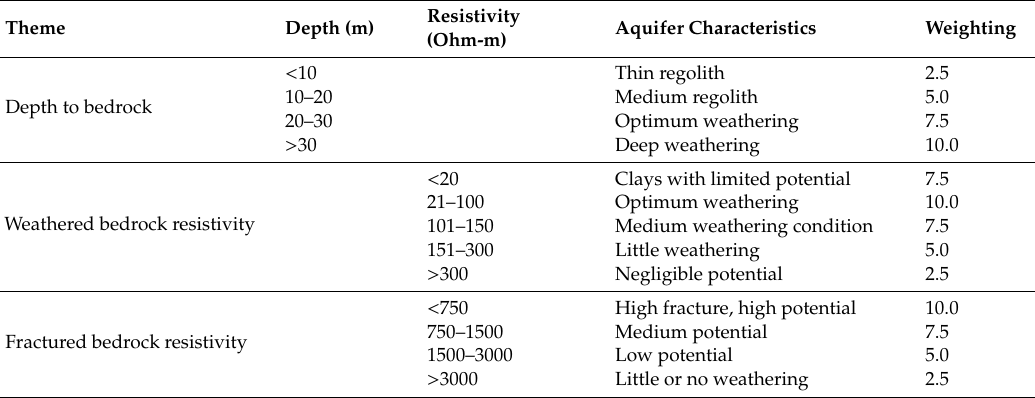
Table 2. Aquifer potential as a function of depth to bedrock, weathered bedrock resistivity and fractured bedrock